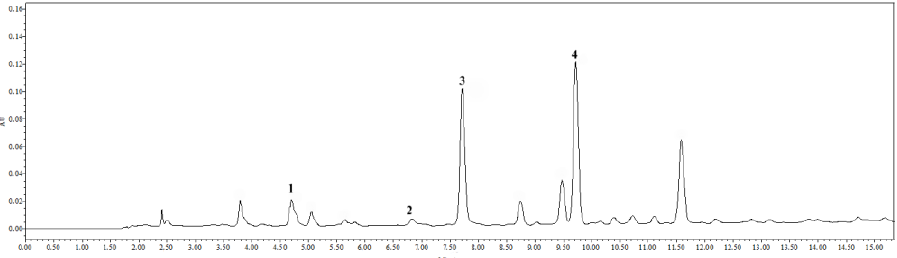
Figure 1. HPLC analysis chromatogram of fresh Echinacea purpurea (L.) Moench roots‘ tincture (1:5). Identified phenolic acids as follows: 1—chlorogenic acid, 2—caftaric acid, 3—caffeic acid, and 4—cichoric acid. Table 1. Results of Echinacea purpurea (L.) Moench fresh roots’ tincture (1: 5) phenolic acid’s quan- tity (as equivalent to caffeic acid) determination.